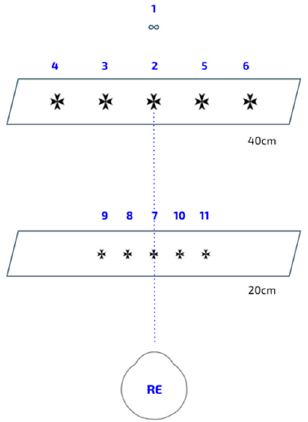
Figure 3. Order of the experimental measurements from 1 to 11 (first and last, respectively).